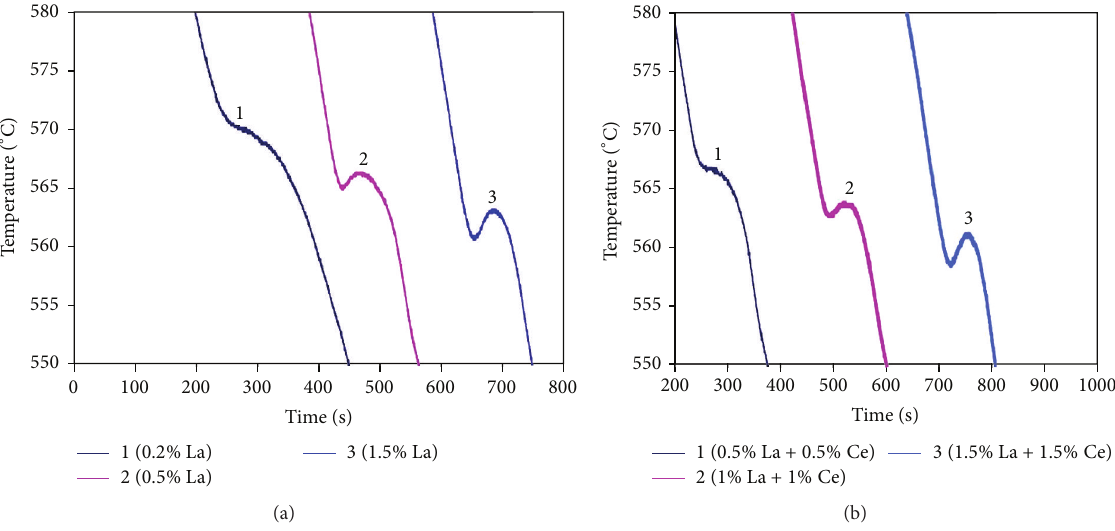
Figure 7: Examples of Al-Si eutectic undercooling in 356 alloy after (a) La and (b) La + Ce